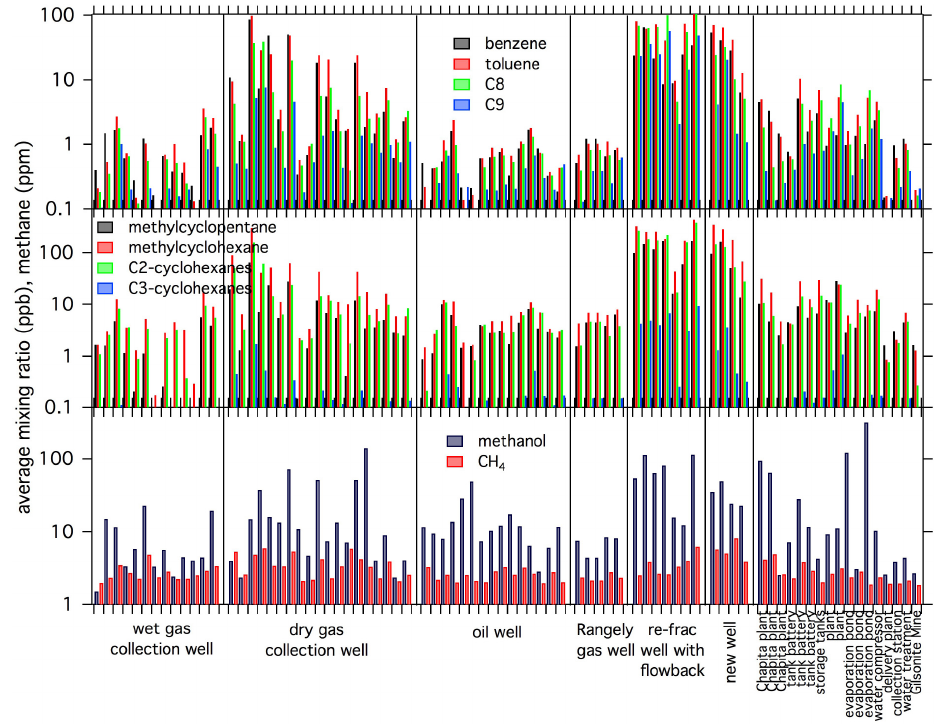
Figure 7. The average mixing ratios of various VOCs (aromatics, cycloalkanes, methanol and methane) observed close to individual point sources in the Uintah Basin and in Rangely,